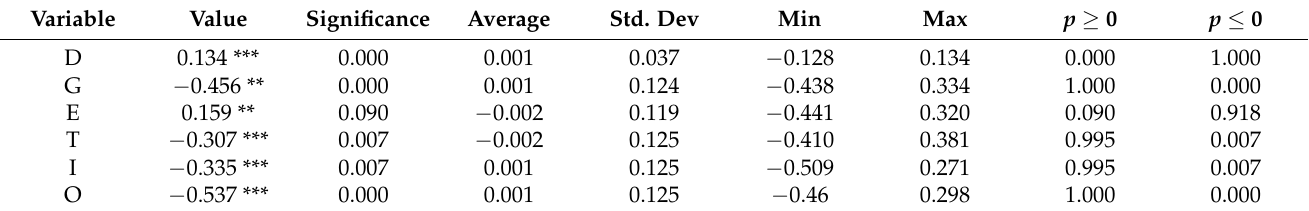
Table 5. Results of the QAP correlation analysis of the matrix Q and influencing factors (2020).